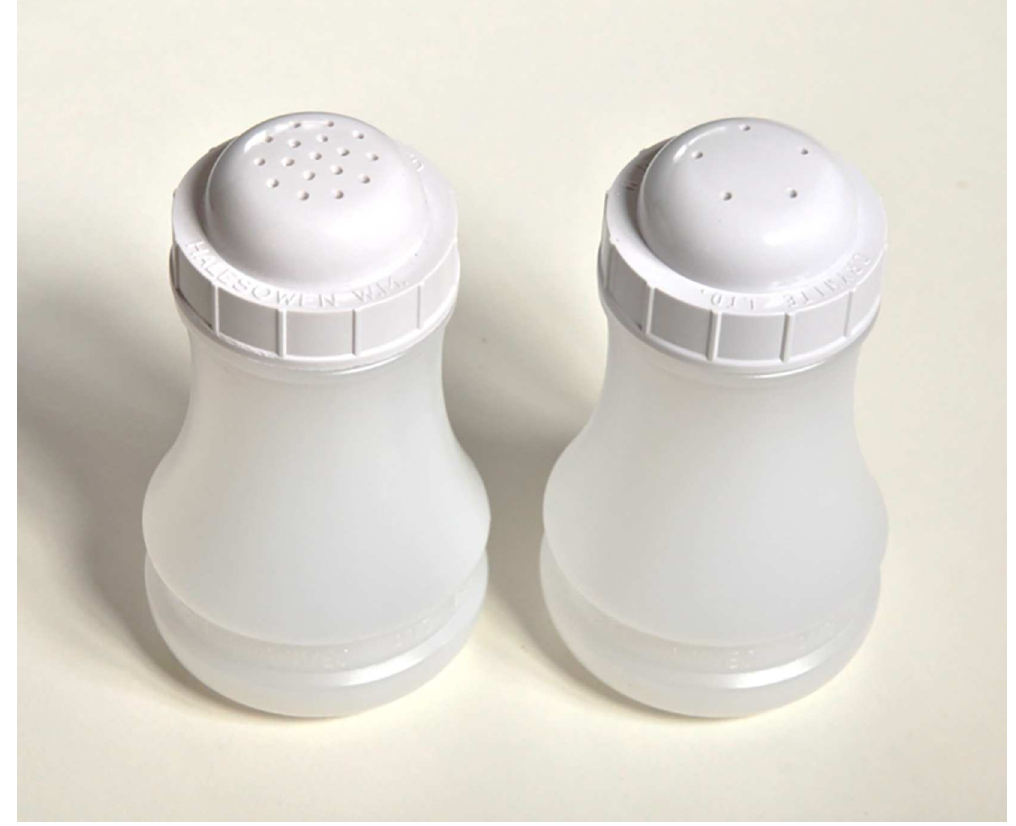
Fig 1. 17 (left) and five (right) holed salt shakers used in UK Fish & Chip shops. Image credit: Martin White.